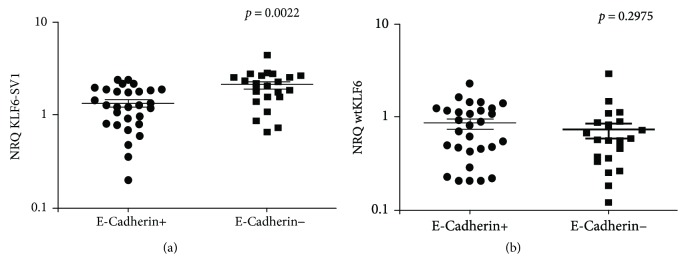
Correlation of wtKLF6 and KLF6-SV1 with the expression of E-cadherin and cyclin D1. Association between the expression levels of E-cadherin with KLF6-SV1 (a) and wtKLF6 (b) in tumor tissues. E-Cadherin+ (NRQ ≥ 0.1) and E-cadherin− (NRQ < 0.1).